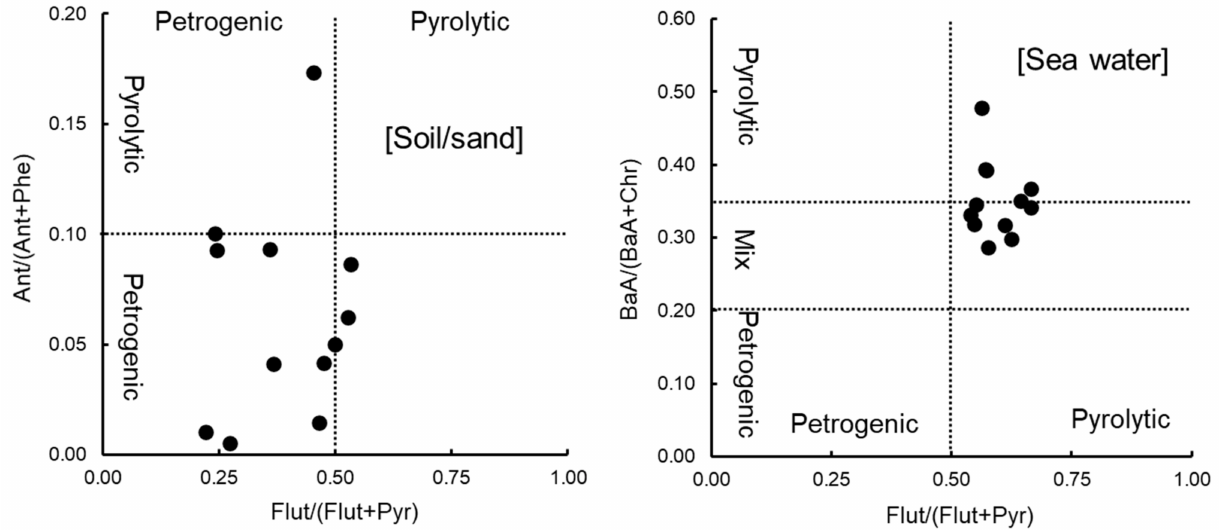
Figure 8. Diagnostic ratios calculated for soil and sand samples and seawater